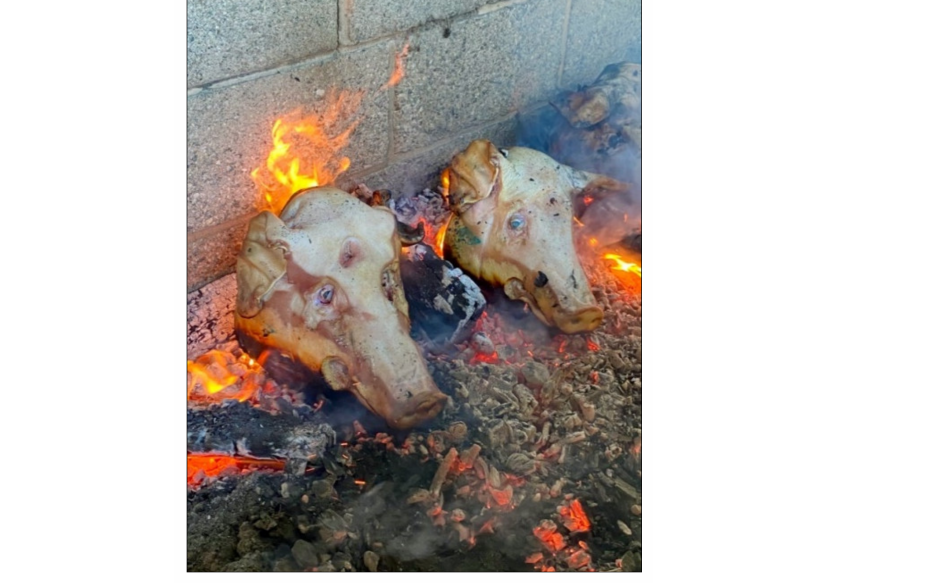
Figure 3. Sample placement.